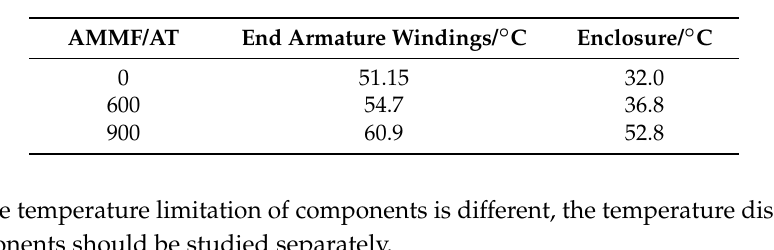
Table 6. Calculation Temperature of machine components under Different AMMF.